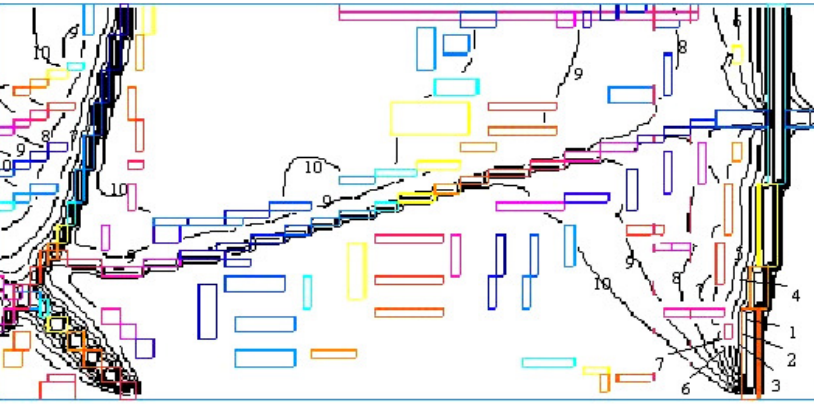
14 pav. Žirmūnų ir Minties g. sankryža. CO, mg/m, sklaidos modeliavimo izolinijos (juoda spalva): 1 − 14,0; 2 − 12,45; 3 − 10,895; 4 − 9,34; 5 − 7,785; 6 − 6,23; 7 − 4,675; 8 − 3,12; 9 − 1,565; 10 − 1,0. Foninė koncentracija 0,5 mg/m Fig. 14. Crossing of Žirmūnų-Minties streets. CO, mg/m, the isolines of scatter modelling (black colour): 1 − 14,0; 2 − 12,45; 3 − 10,895; 4 − 9,34; 5 − 7,785; 6 − 6,23; 7 − 4,675; 8 − 3,12; 9 − 1,565; 10 − 1,0. Background concentration 3 0,5 mg/m . Southeast wind 3 m/s. The palling image in the coloured